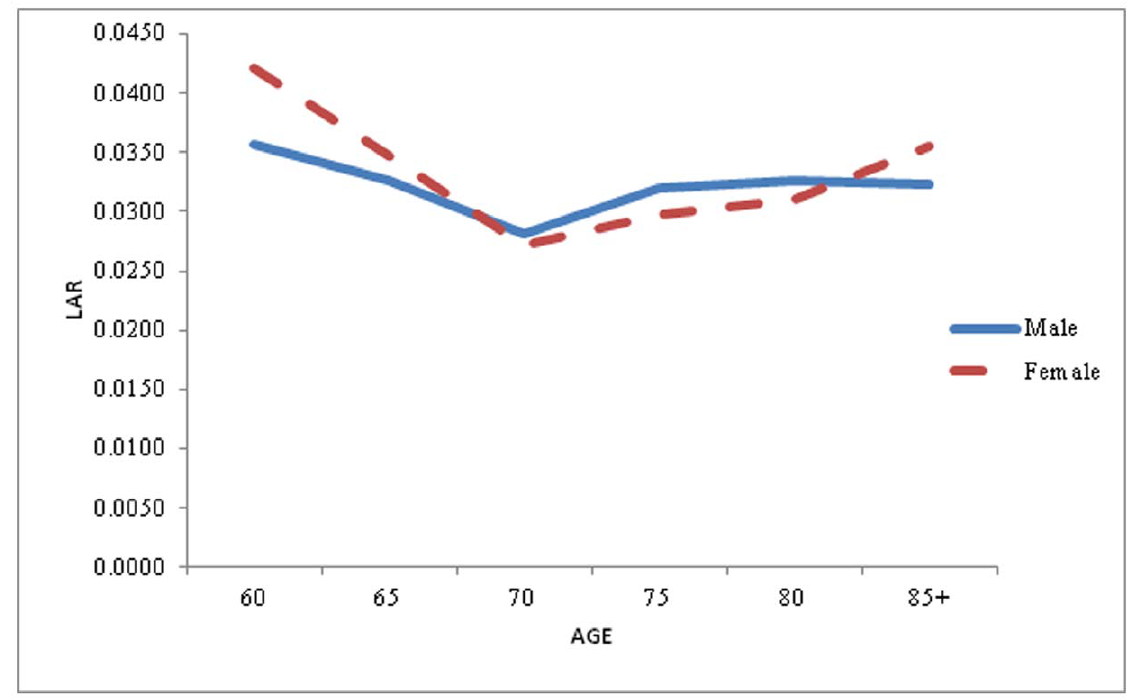
Figure 2. Life Table Aging Rate (LAR) for Male and Female in the older age, India, 1993. doi:10.1371/journal.pone.0050941.g002 PLOS ONE |